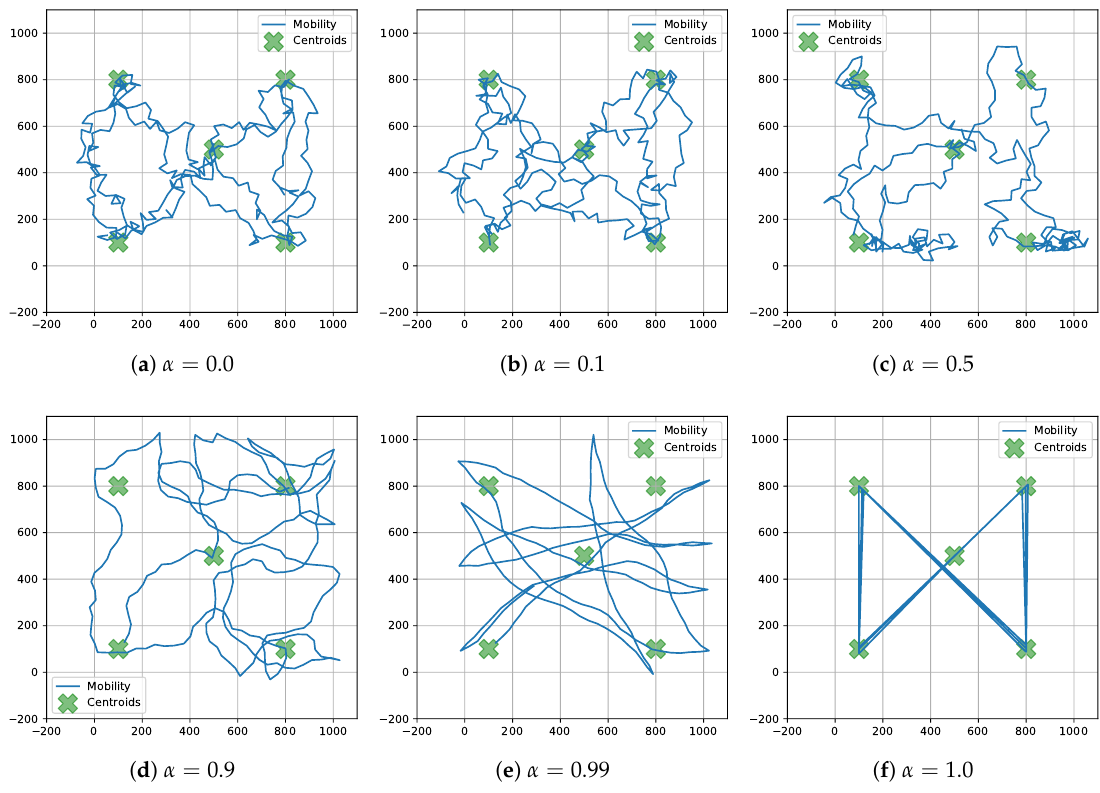
Figure 4. Varying α values for recurrent self-similar Gauss–Markov mobility. Table 2. Simulation